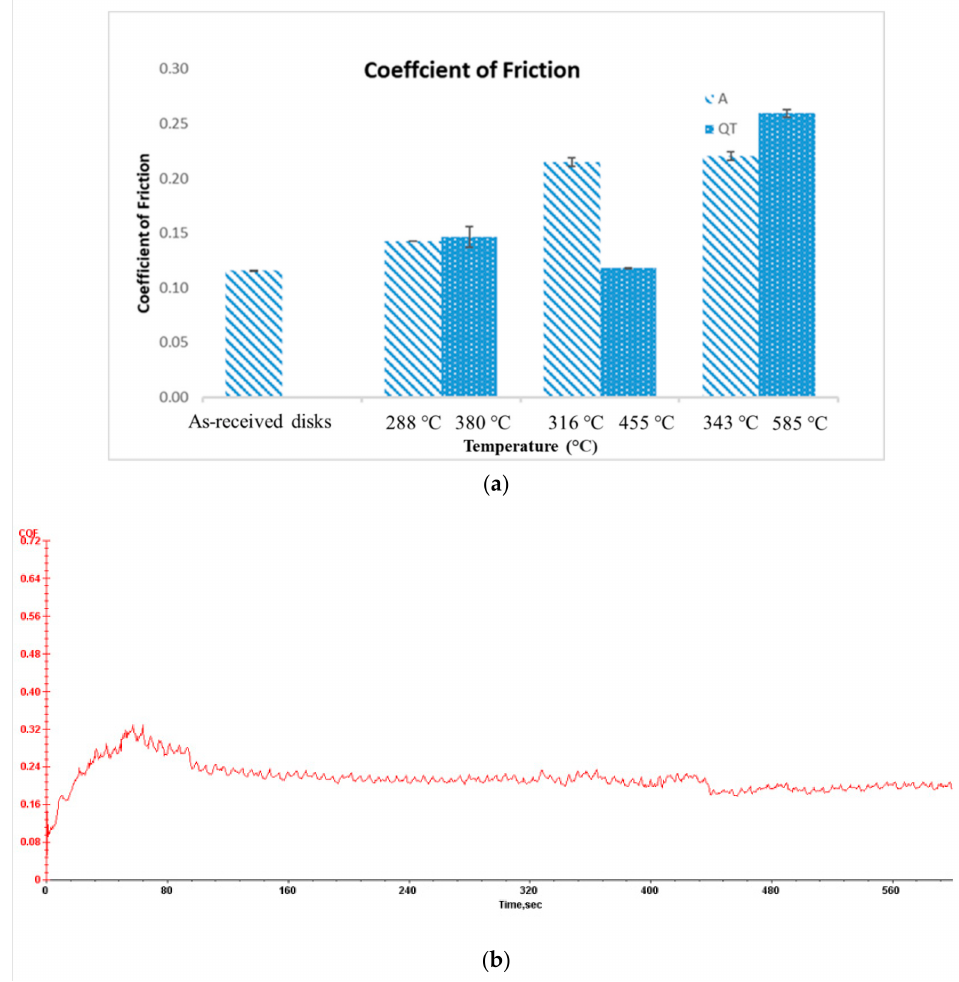
Figure 5. ( a ) Coefficient of friction of austempered disks and quenched-tempered disks; ( b ) COF vs. sliding time for 288 ◦ C austempered